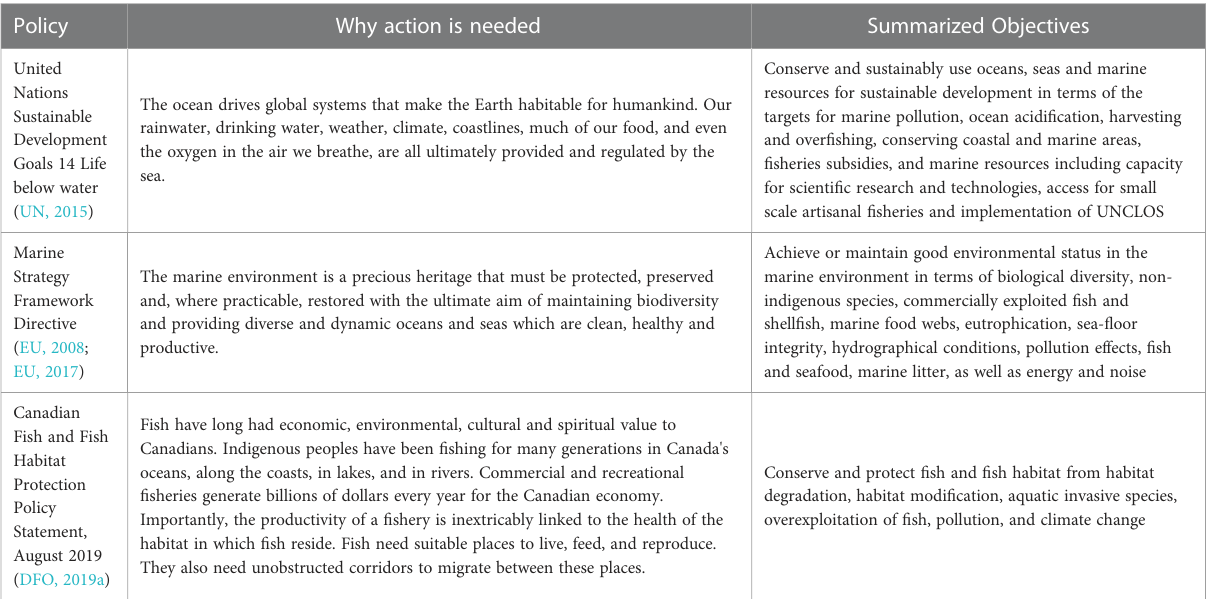
TABLE 1 Examples of environmental policy rationales and objectives (EU, 2008; UN, 2015; EU, 2017; DFO, 2019a).